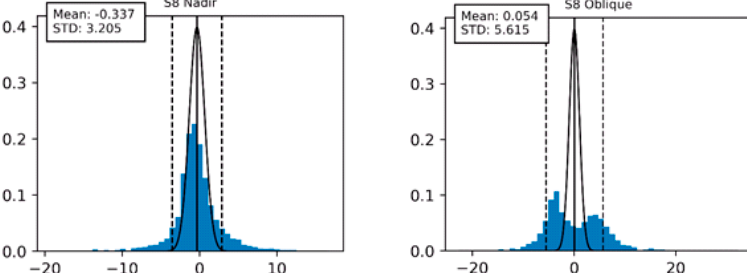
Figure 8. Example of SLSTR L1 per-pixel uncertainty validation for the nadir ( left ) and oblique ( right ) views. Blue: histogram of normalized differences. Black: normal distribution (solid) and 3-sigma values (dashed). The comparison reveals a general under-estimation of the uncertainties, while the bimodal distribution on the oblique viewpoints to an instrumental effect not properly accounted for in the uncertainty model. Reprinted from [25].